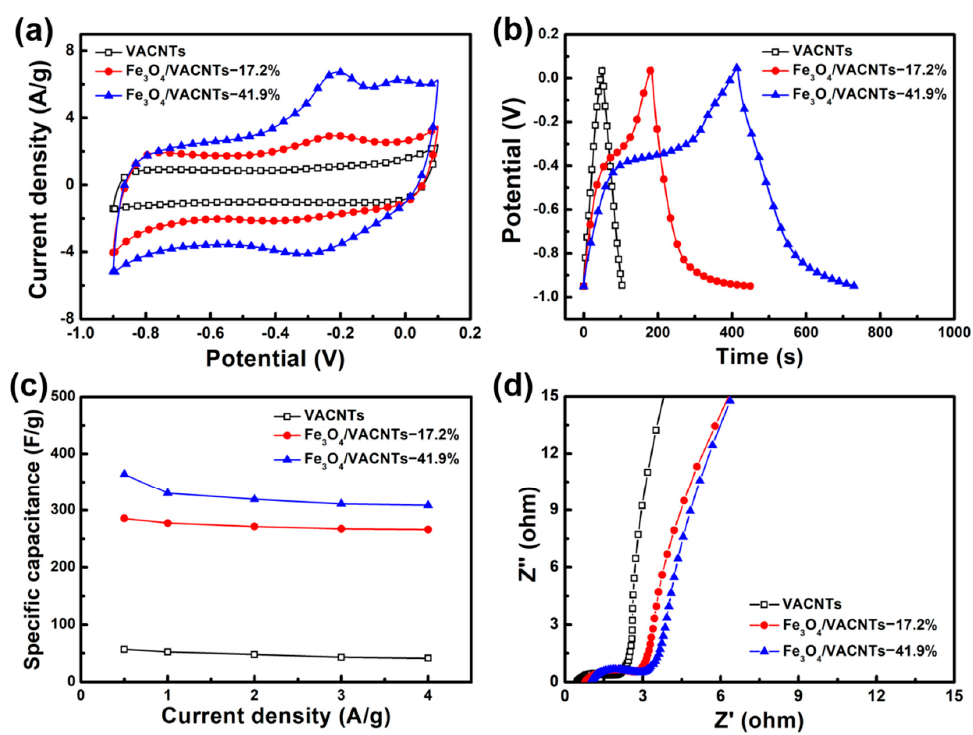
Figure 5. Electrochemical performance of the pure VACNTs and Fe 3 O 4 /VACNTs composites with different Fe 3 O 4 loading: ( a ) CV curve at 20 mV/s; ( b ) GCD curves at 0.5 A/g; ( c ) Specific capacitances at various current densities; ( d ) EIS spectra. Table 1. Comparison of the electrochemical performance with other nanocomposites based on Fe 3 O 4 .